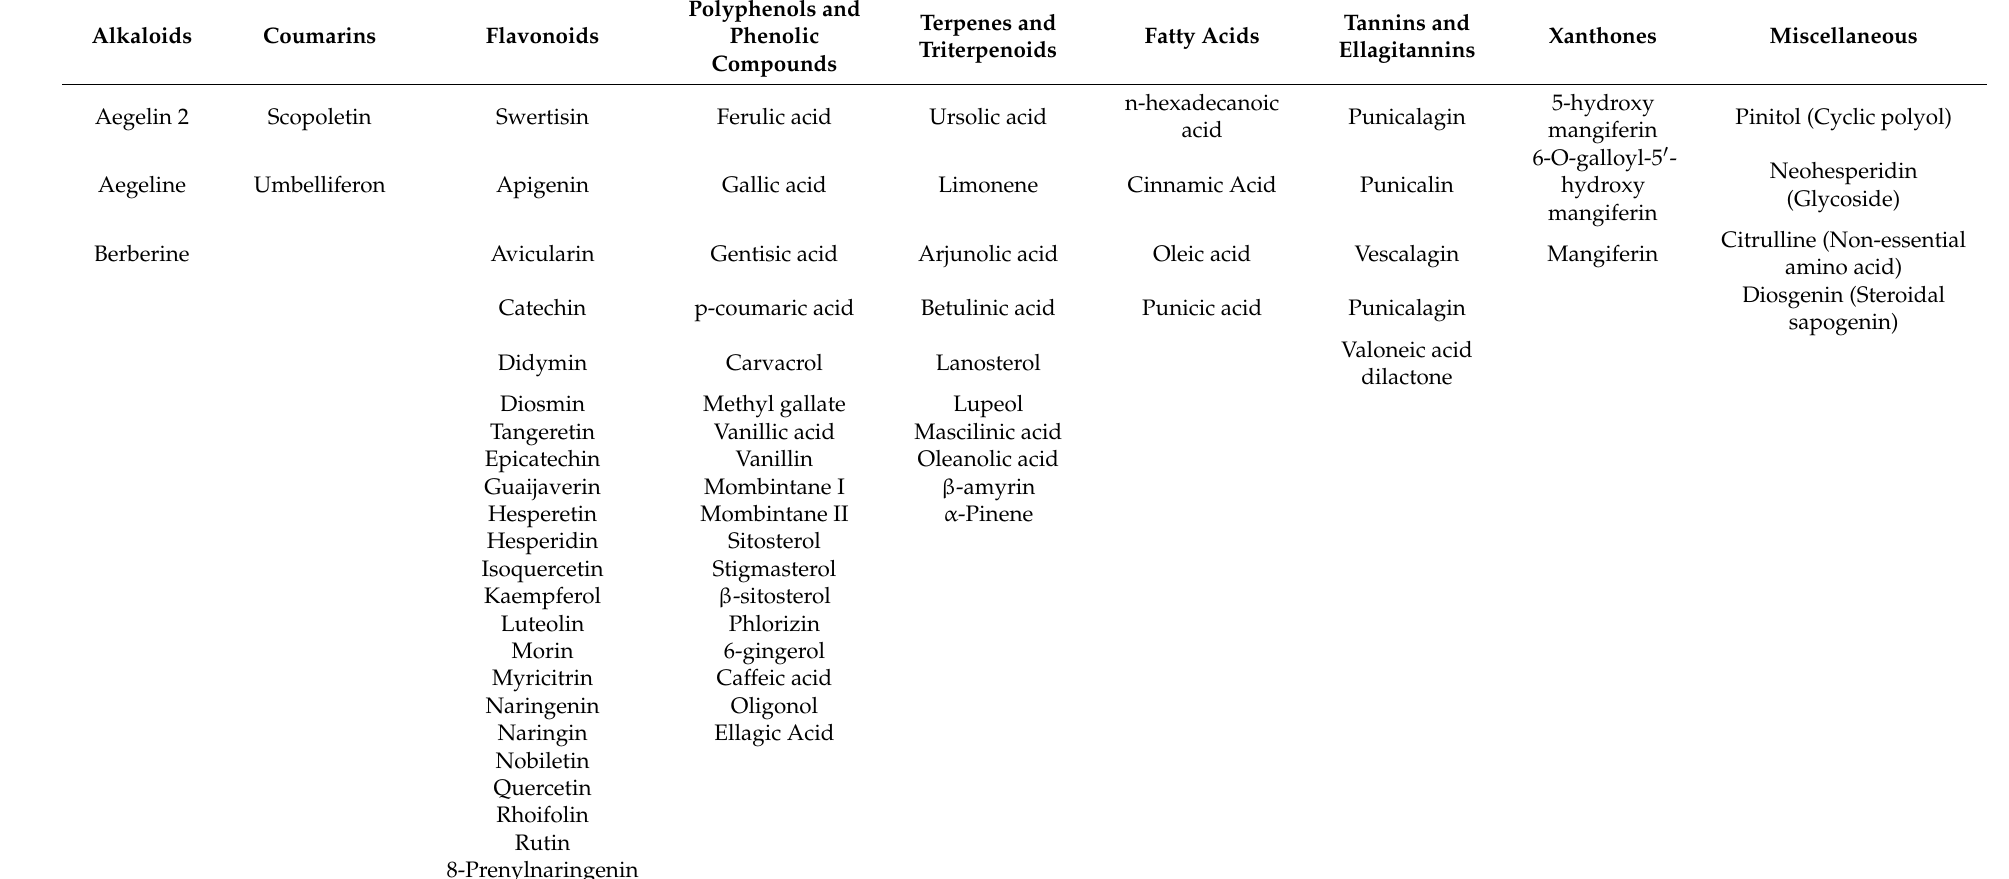
Table 2. Chemical class-wise prospective antidiabetic phytochemicals found in fruit